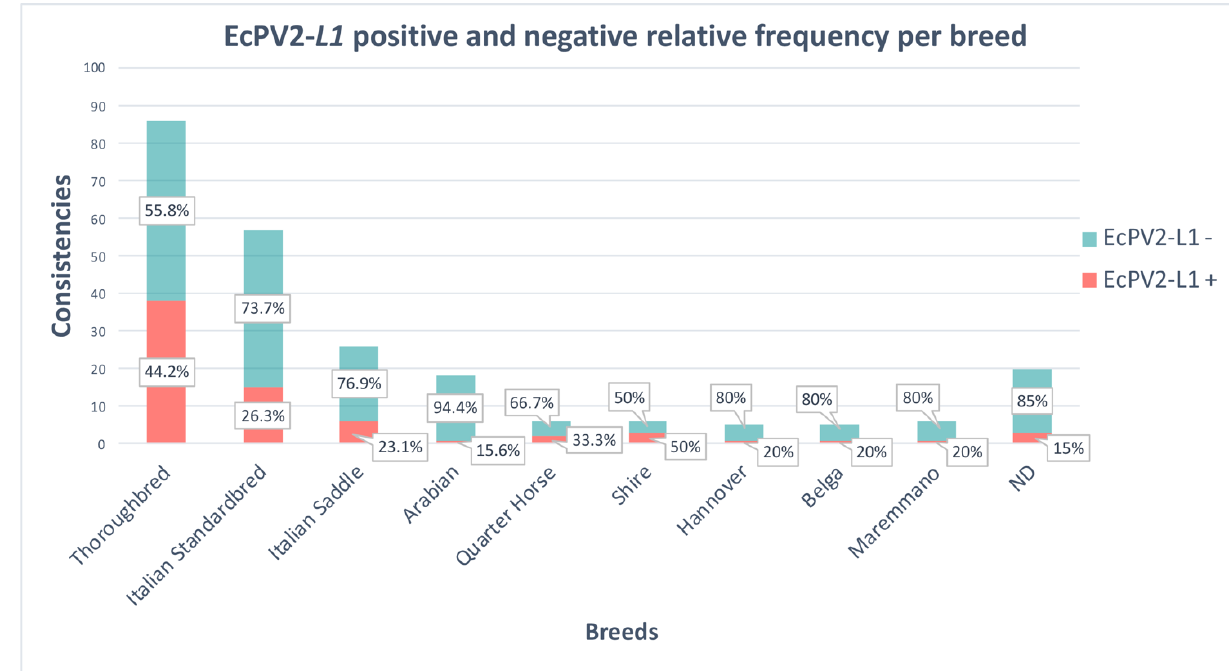
Figure 1. EcPV2 genoprevalence in the different breeds. Bars represent the number of sampled animals for each breed with the orange part depicting the positivity for EcPV2-L1 and the green part the negativity for the virus (with relative percentages).